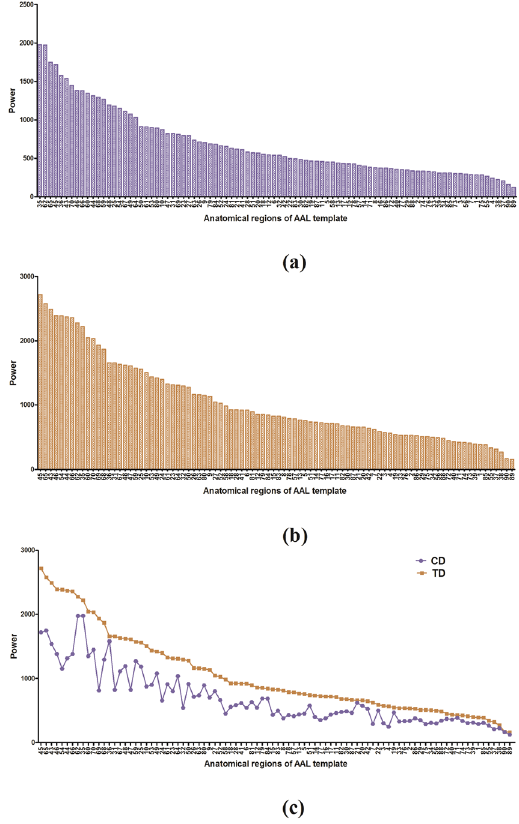
Figure 4. Power distribution and comparison. CD group in ( a ) and TD group in ( b ) express the power distribution of brain regions in descending order of power.; ( c ) expresses the comparison between CD and TD groups with the order of brain regions in panel